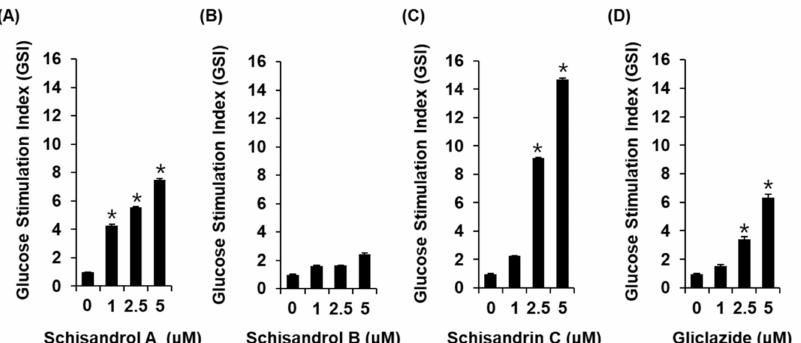
Figure 2. Effects of three lignans (schisandrol A, schisandrol B, and schisandrin C) on glucose- stimulated insulin secretion in INS-1 cells. Insulin secretion in INS-1 cells after 1 h incubation with basal (2.8 mM) and stimulant (16.7 mM) concentrations of glucose in the presence or absence of ( A – C ) schisandrol A, schisandrol B, schisandrin C, and ( D ) gliclazide (positive control) assessed by insulin secretion assay. The data represent the mean ± S.E.M., n = 3, * p < 0.05 compared with the